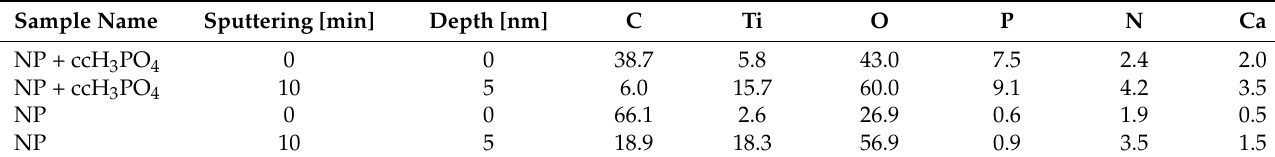
Table 5. Element composition of untreated control and ccH 3 PO 4 -treated NP surfaces. Ten times more phosphorus was detected on the ccH 3 PO 4 -treated NP surface than on the control before and after sputtering. Approximately three times more calcium appeared on the ccH 3 PO 4 -treated NP surface than on the untreated control even after sputtering. Carbon and nitrogen measurements were presumably contaminations from the ambient air.